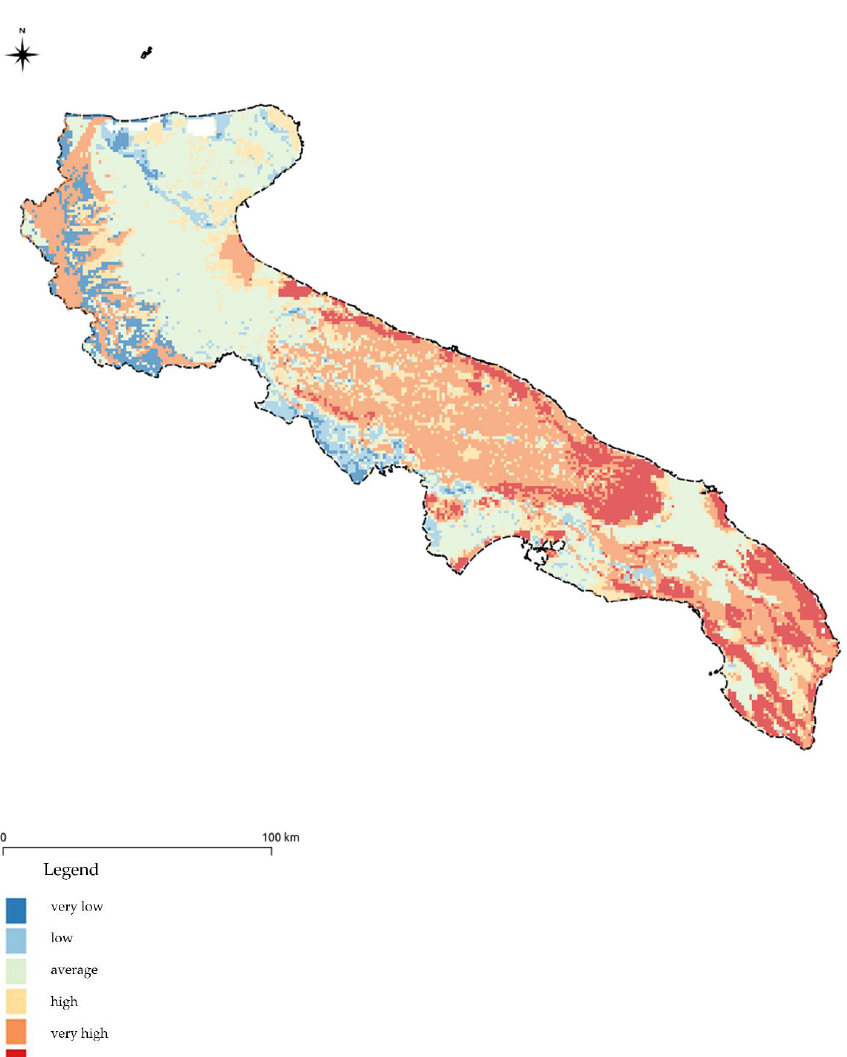
Figure 12. Values of intrinsic vulnerability calculated through the application of the DRASTIC model updated to